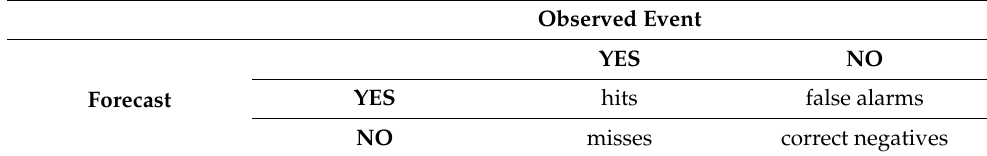
Figure 5. Histogram of daily precipitation values (mm) at the CIRA site over the considered period: observational and model data for the nearest grid point and grid box. Table 2. Contingency table and related